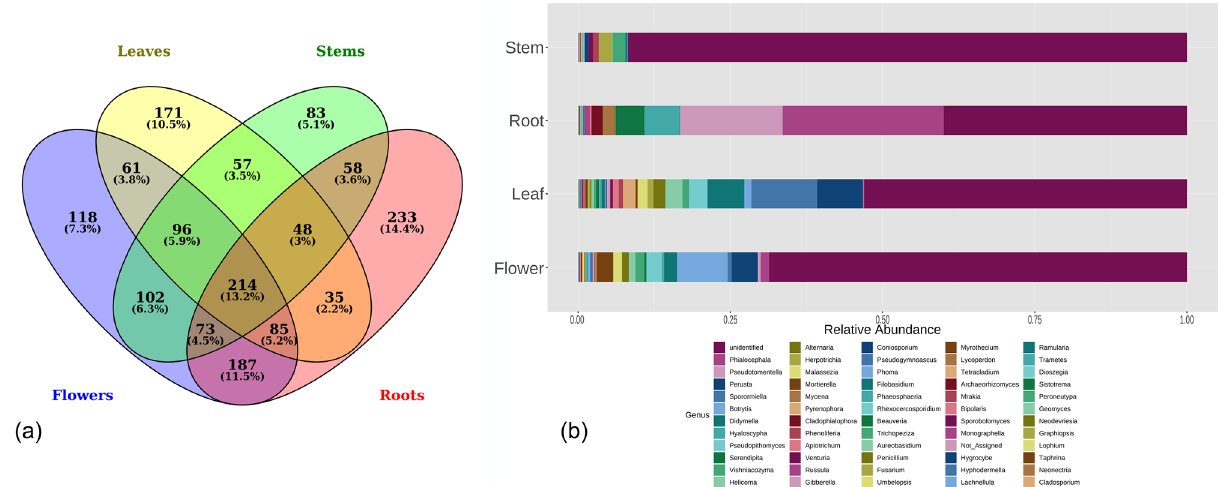
Figure 4. OTU distribution in the different samples and fungal genera in the core OTUs. ( a ) Venn diagram of the OTUs from the different plant organs; ( b ) relative abundance of the genera within the 214 core OTUs.